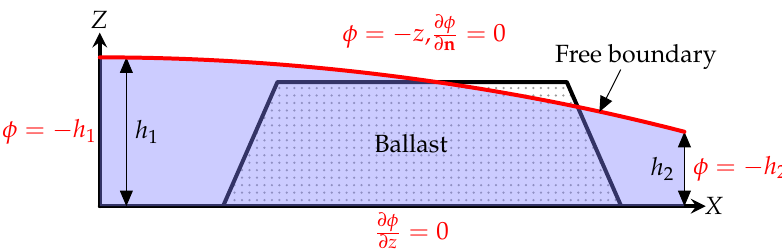
Figure 2. Schematic diagram showing the boundary conditions. The governing equation is ∇ · ( K s ( x ) · ∇ φ ) = 0, where K s ( x ) is